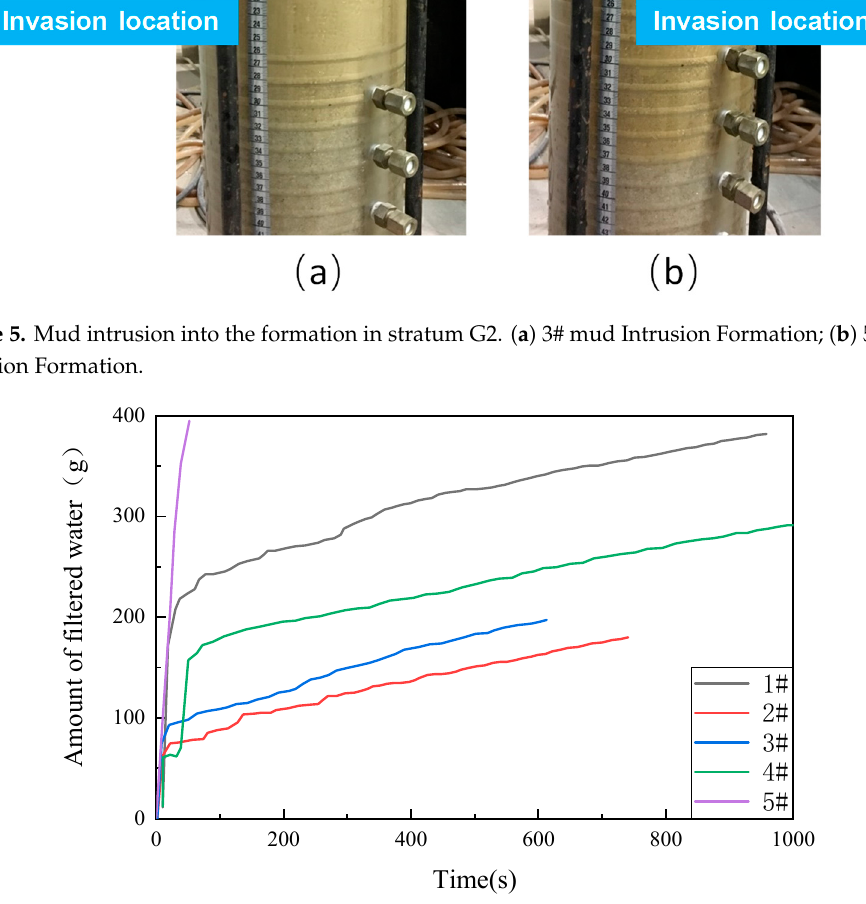
Figure 6. Changes in the amount of filtered water with the loading process in stratum G2.